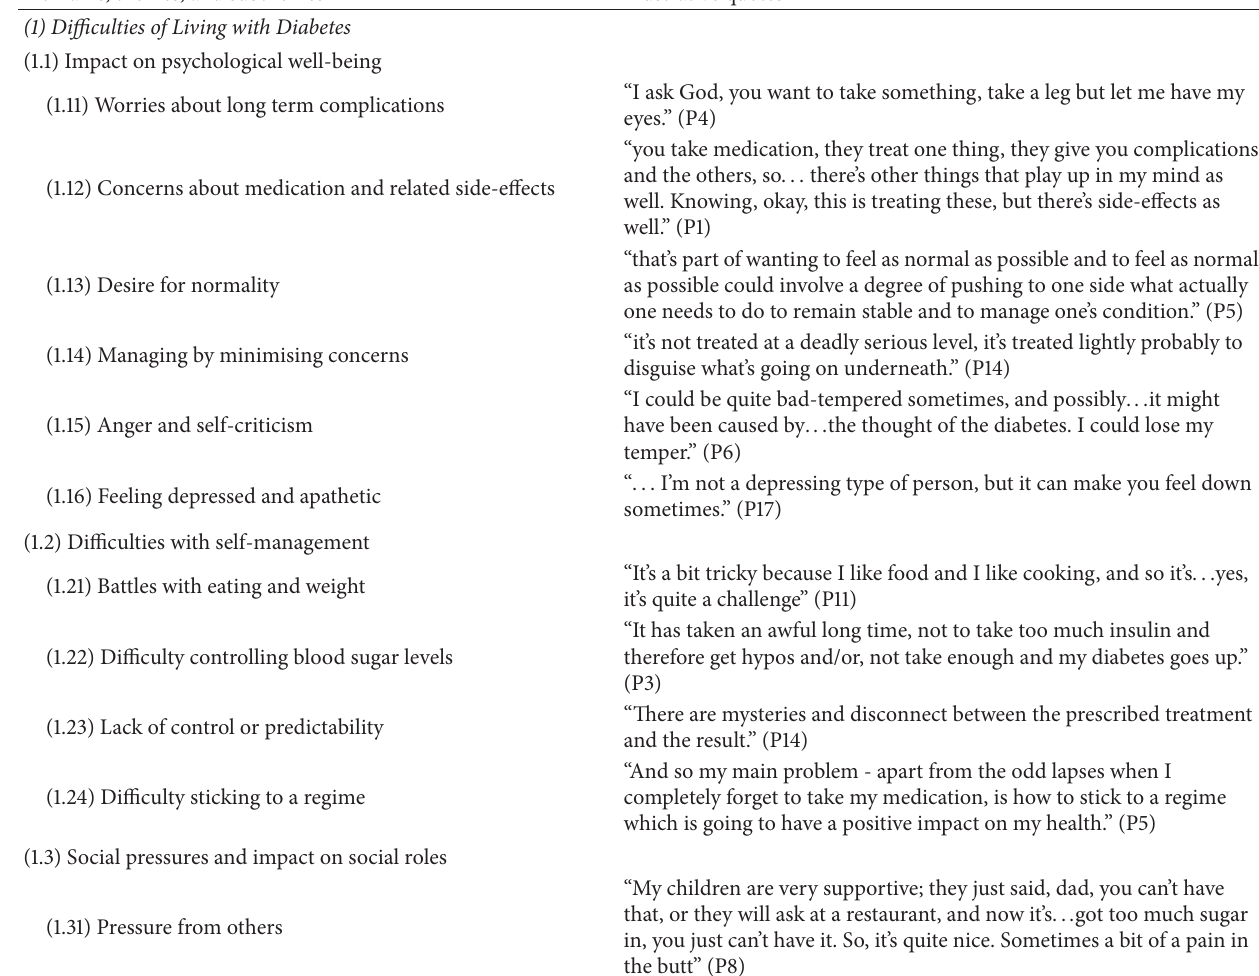
Table 5: Domains, themes, su-themes, and illustrative quotes for the preintervention data. Domains, themes, and